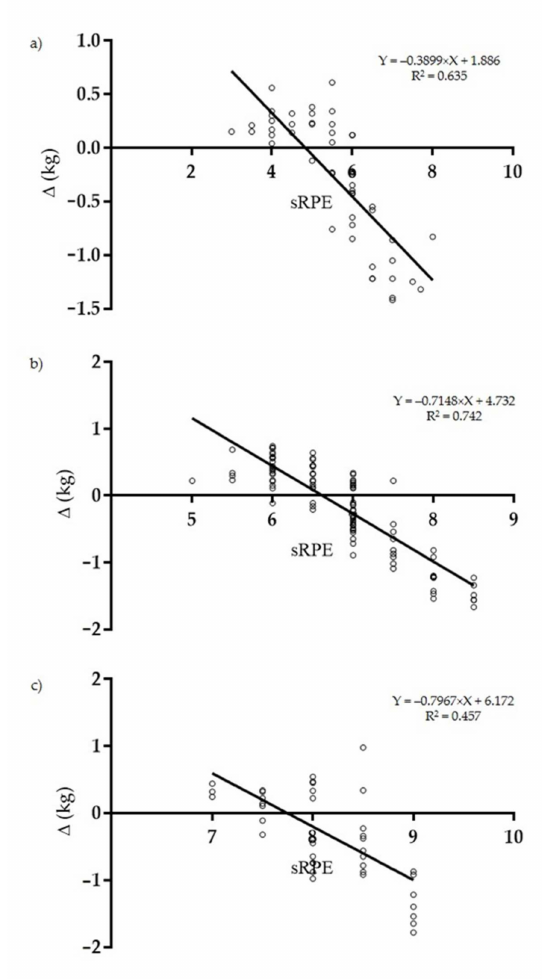
Figure 3. Linear regression between sRPE (AU) and pre- and post-training ∆ (kg) variations of training sessions displaying <100 TRIMP points ( a ); 100–200 TRIMP points ( b ) and >200 TRIMP points ( c